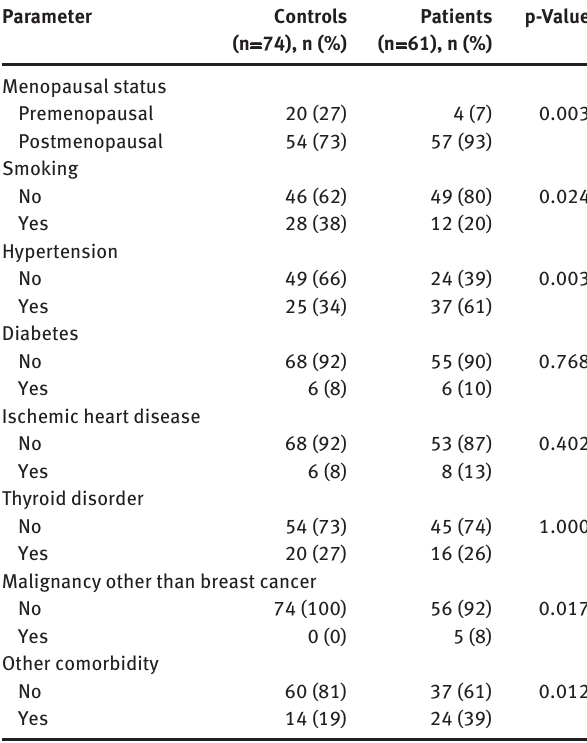
Table 1 Subject history in patients and